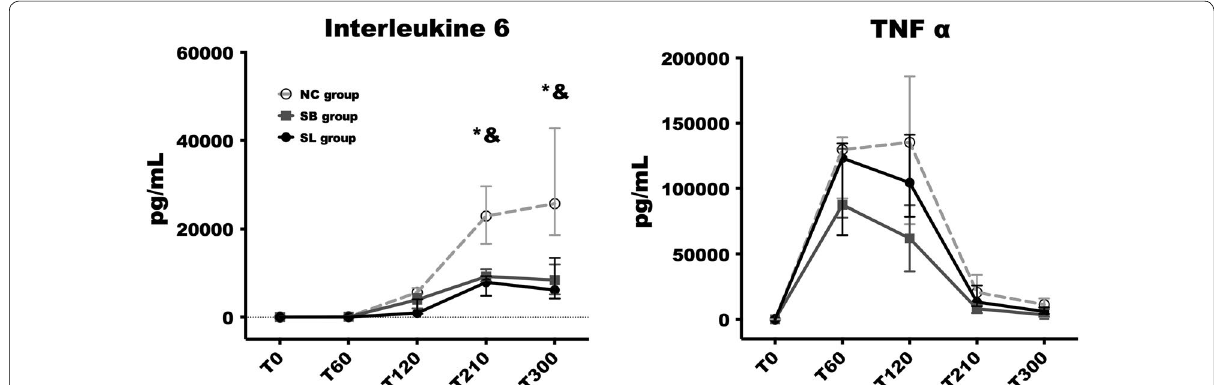
5); squares and grey line: SB group =